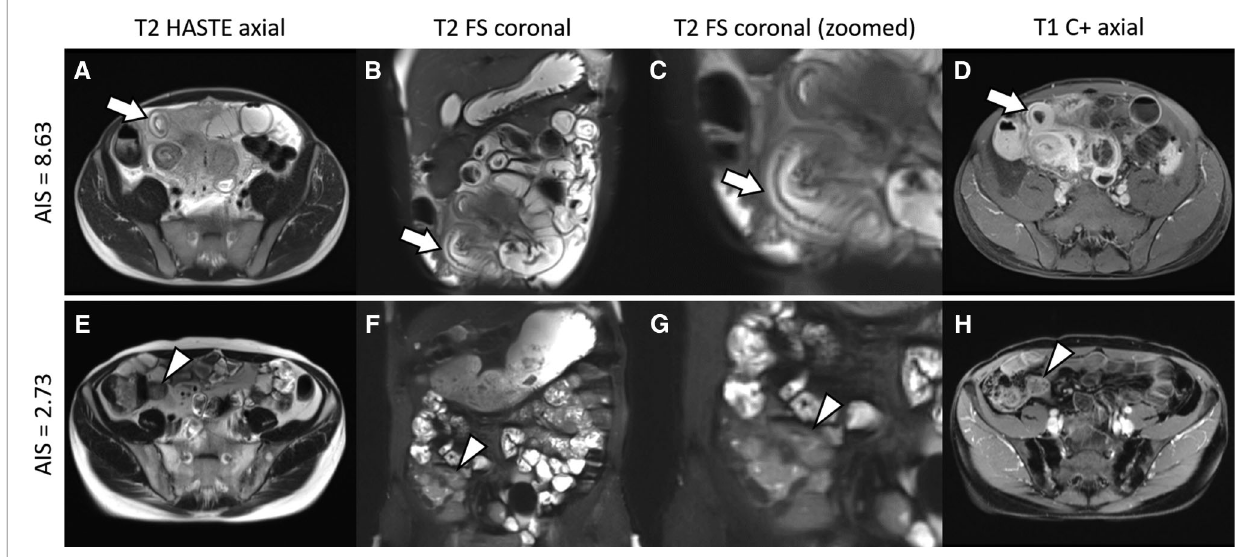
FIGURE 3 | Representative cases. Upper row: A 37-year-old man with ileal Crohn ’ s disease and an increased acute in fl ammation score (AIS) of 8.63. The terminal ileum (arrows) shows the following imaging features of acute in fl ammation: ( A ) mural thickening of up to 9 mm; ( B , C ) a marked increase in the signal of the bowel wall consistent with edema; and ( D ) a marked contrast enhancement. Histopathology revealed severe ulcerative ileitis with active in fl ammation. Lower row: A 37-year-old man with ileal Crohn ’ s disease and a decreased AIS of 2.73. The terminal ileum (arrowheads) is characterized by the following fi ndings: ( E ) no measurable mural thickening; ( F , G ) minor increase in the signal of the bowel wall indicating edema; and ( H ) minor contrast enhancement. Histopathology revealed focally dilated ileal wall with stromal fi brosis and no active in fl ammation. Note that supplementary contrast-enhanced images are shown to provide a comprehensive case overview, although they are not a part of the AIS assessment. HASTE, half-Fourier acquisition single-shot turbo-spin-echo sequence; FS, fat saturation; C+, contrast